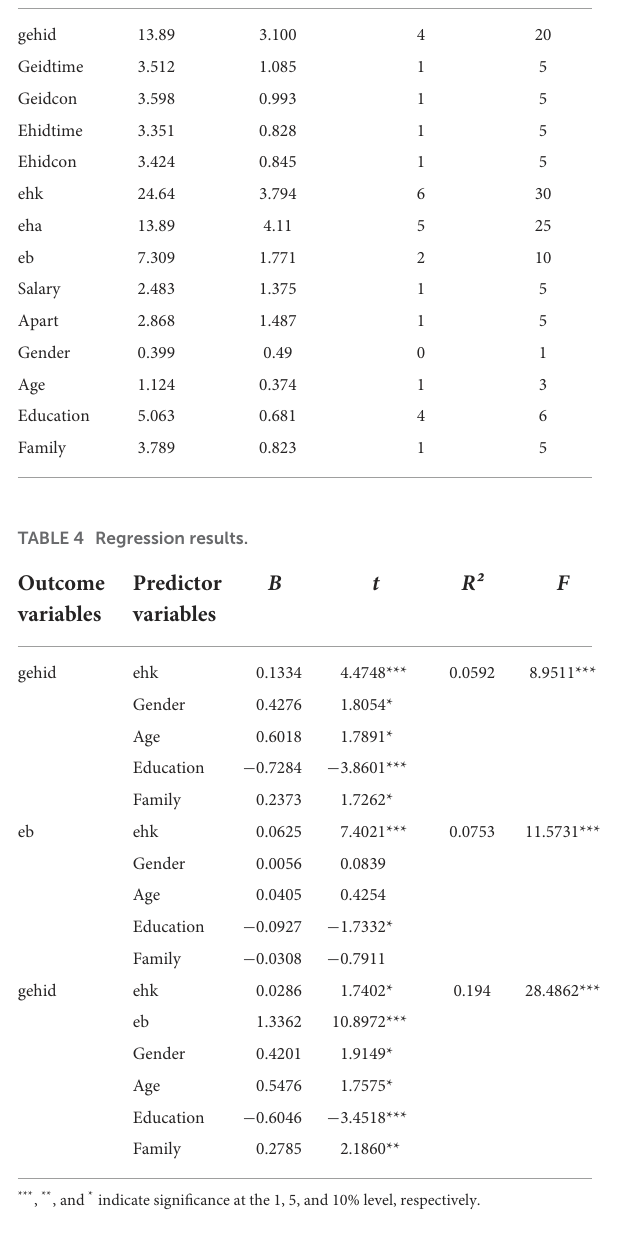
TABLE 3 Descriptive statistics.